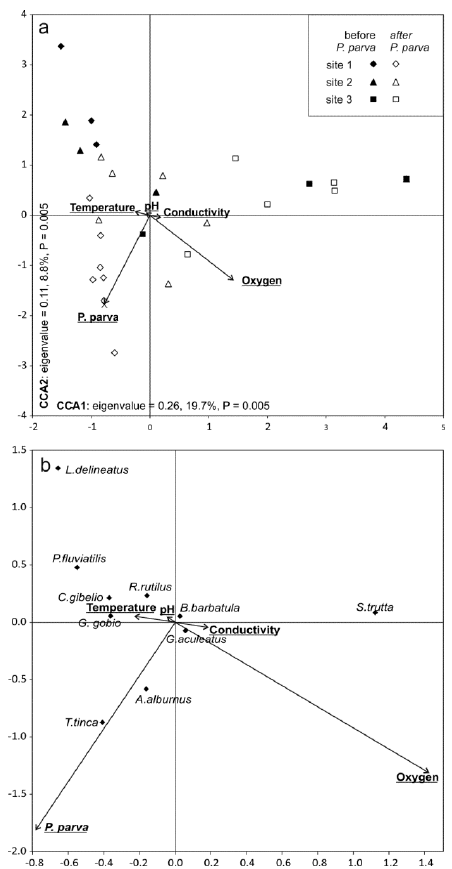
Figure 3. Canonical correspondence analysis ordination of the studied samples: ( a ) fish species ( b ) and environmental variables (shown as arrows). The length of an arrow along a particular axis denotes the strength of the correlation between a given environmental variable and that axis. Species and samples are located according to their distribution along environmental gradients denoted by arrows. Species are located near the samples for which they are typical. Filled symbols are pre-invasion and clear symbols are post invasion for S1 ( ♦ ), S2 ( ∆ ), and S3 ( (cid:3)